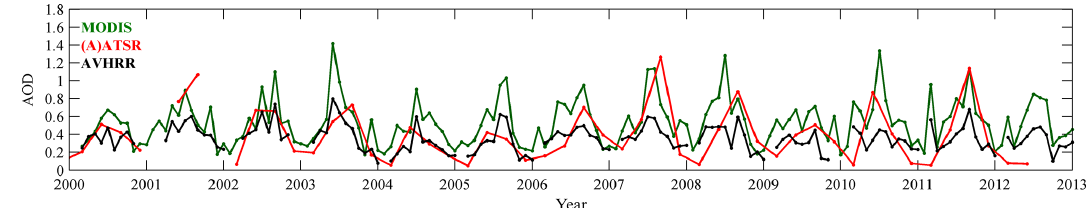
Figure 10. Comparison of AOD time series over the Beijing AERONET site retrieved from the satellite sensors AVHRR, MODIS and (A)ATSR for the overlapping years 2000–2015. Note that for AVHRR and MODIS monthly mean AOD data are plotted, while for (A)ATSR they are seasonal means that may provide a shift in the extreme values.